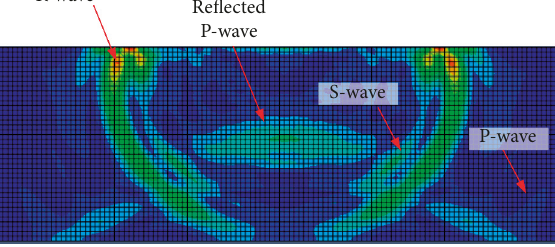
Figure 11: Wave propagation simulation. Table 3: Comparison of experimental and analytical